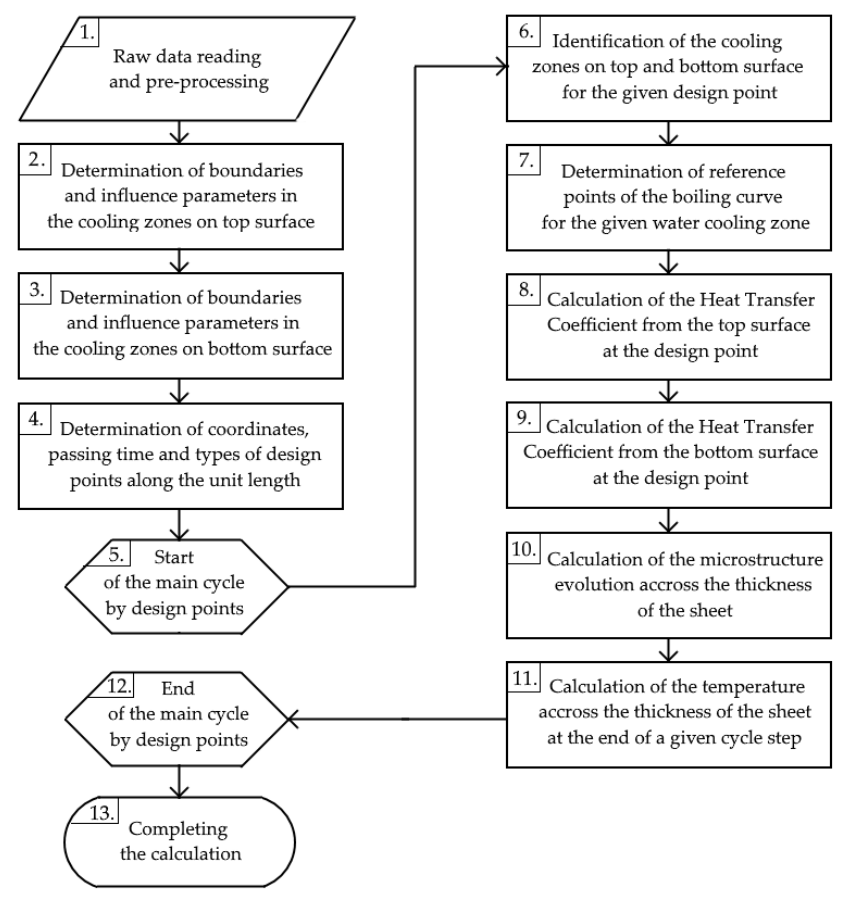
Figure 2. Block diagram of the cooling model.